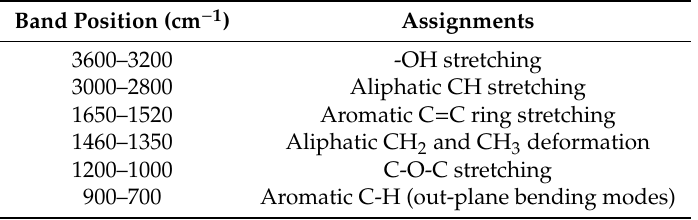
Table 2. The band assignments for functional groups in coal Fourier transform infrared (FTIR) spectra